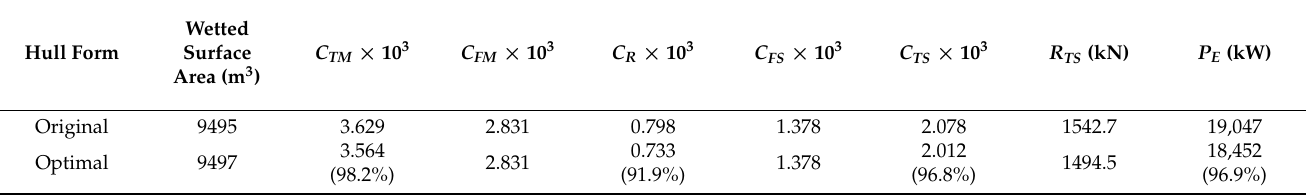
Table 11. Comparison of full-scale performance prediction between original and optimal hull forms at the design speed V S = 24.0 knots ( Fn = 0.260